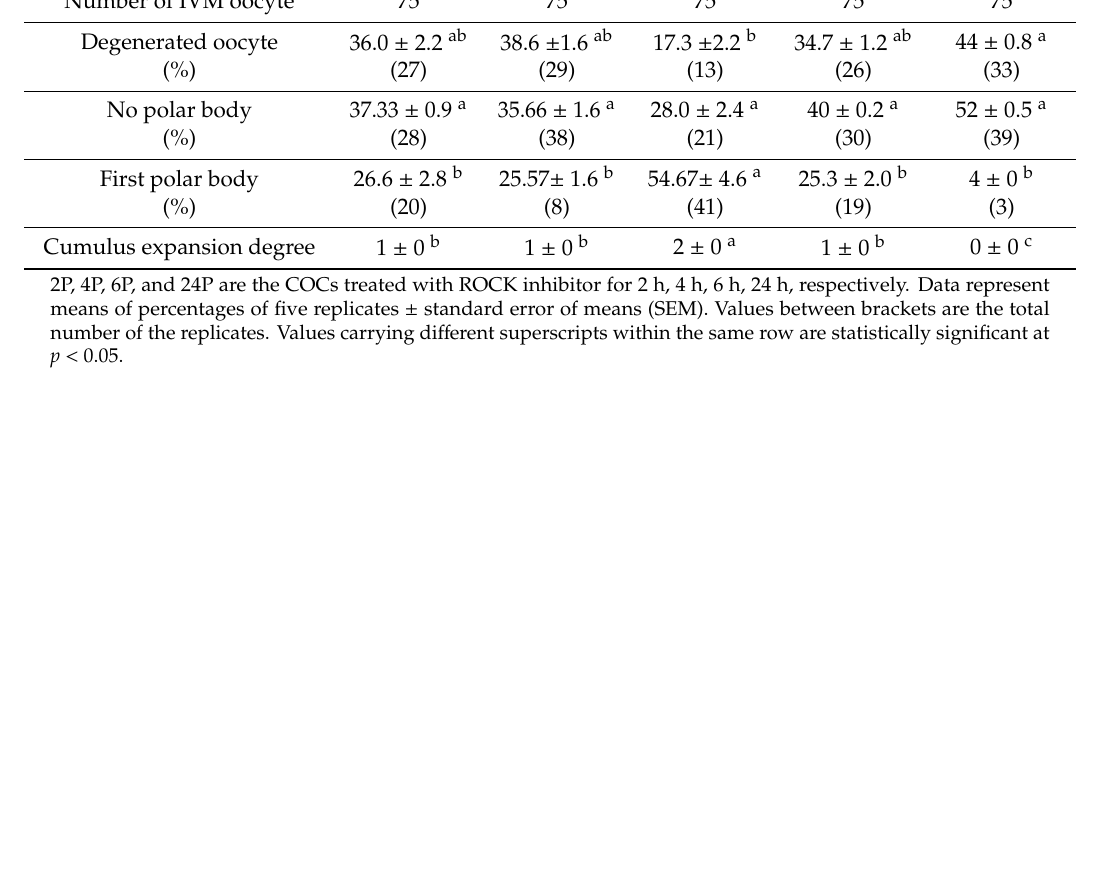
Table 2. E ff ect of ROCK inhibitor on camel cumulus expansion and oocyte in vitro maturation. Parameter